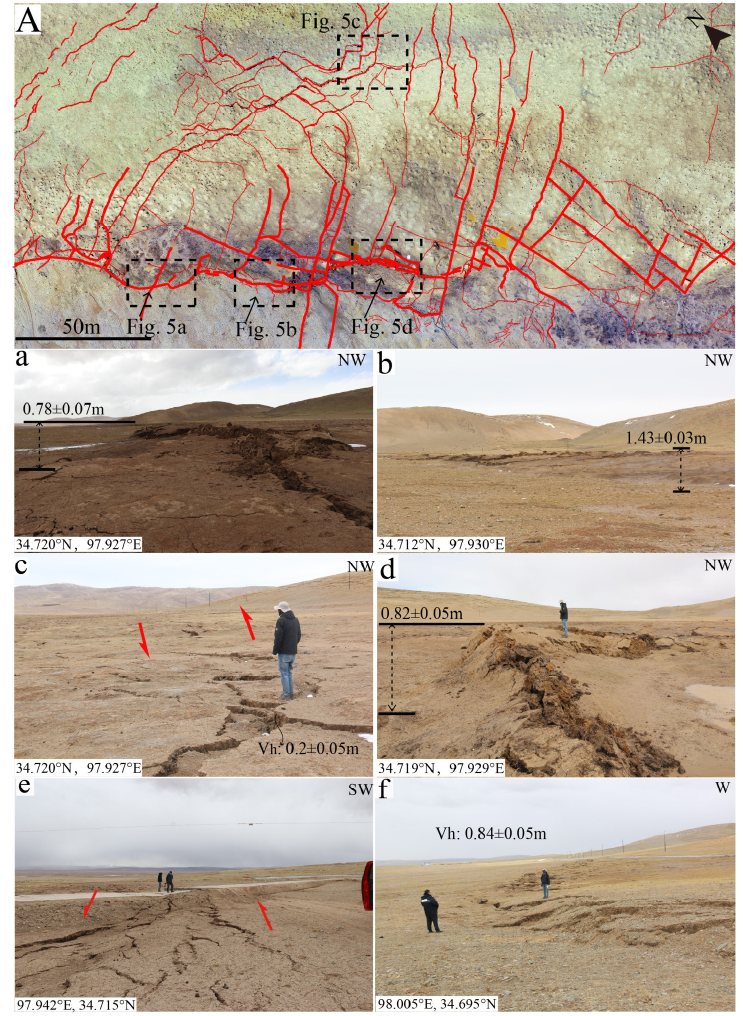
Figure 5. Surface rupture at Jiangcuogongma ( A , a – d ) and Jiangduo village ( e , f ) sites: ( a , b ) continuous pressure ridges; ( c ) right-stepping en echelon extensional cracks; ( d ) pressure ridge on the partial thrust fault; ( e ) extensional cracks developed on rupture zone with about 0.2–0.4 m vertical scarp; ( f ) right-stepping en echelon extensional cracks; here, the south side is down-dropped relative to the north side to form a scarp. ( A ) representative orthophotos of surface rupture on Jiangcuogongma site and the locations of photos ( a – d ). The Jiangduo village site: The Jiangduo village site showed sinistral strike-slip fault- ing with an obvious component of normal faulting (Figure 5e,f). Overall, it strikes NWW 150°, and the surface rupture exhibited the characteristics of alternating ridges and fully separated cracks and fissures in a relatively narrow zone from several meters to about 30 m. Along the rupture, widely distributed en echelon right-stepping sub-segments vary in length from several meters to more than 20 m. The maximum co-seismic vertical displace- ment measured from the field was ~1.5 m. The normal component offset gradually